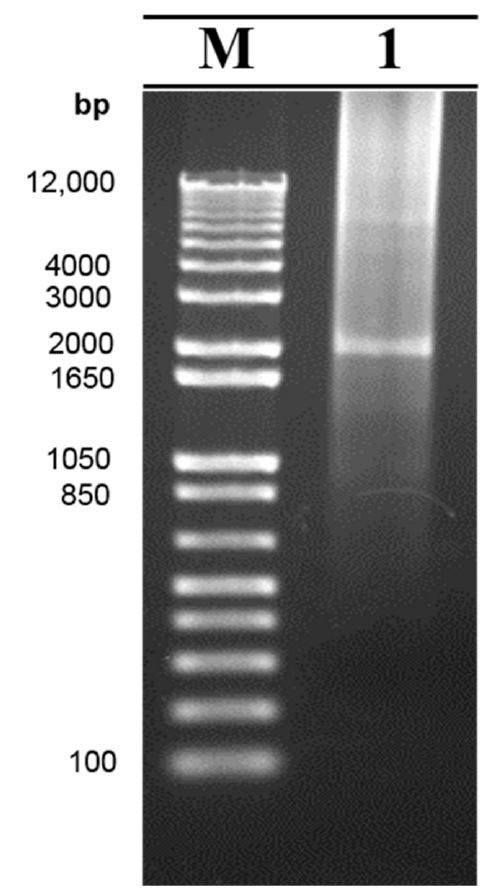
Figure 4. The electrophoretic photograph presenting an in vitro transcribed RNA containing the cis-acting elements of the pKLS3 minigenome and a GFP gene. The plasmid pKLS3_GFP was used as the plasmid DNA template in an in vitro transcription reaction to test the hdv ribozyme function. The hdv ribozyme auto-cleaved the transcribed RNA at its 5 ′ end, resulting in the RNA product containing the cis-acting elements of the pKLS3 minigenome and the GFP gene of approximately 2.2 kb (lane 1). Lane M is a standard molecular weight DNA marker.